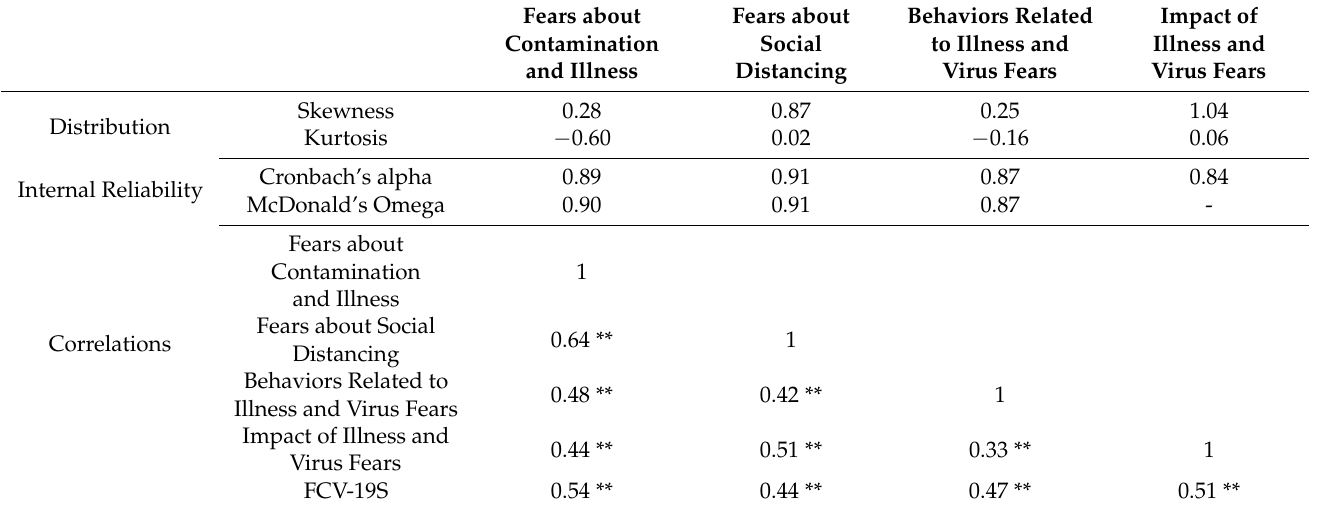
Table 2. Distribution, internal reliability and correlation of Fear of Illness and Virus Evaluation